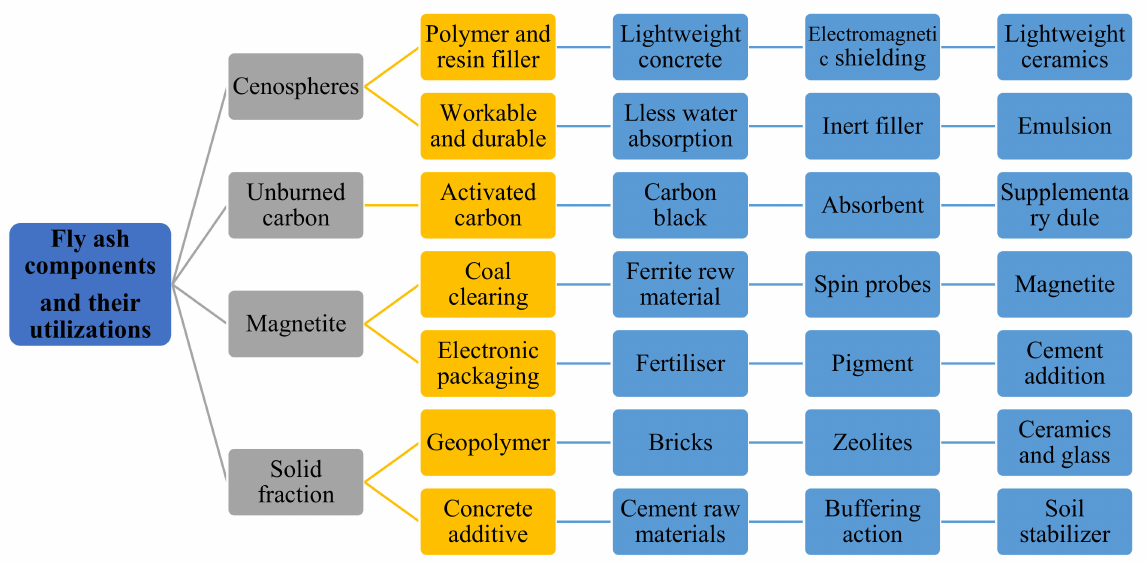
Figure 3. Main constituents of FA and their applications (modified with improvements from Danish